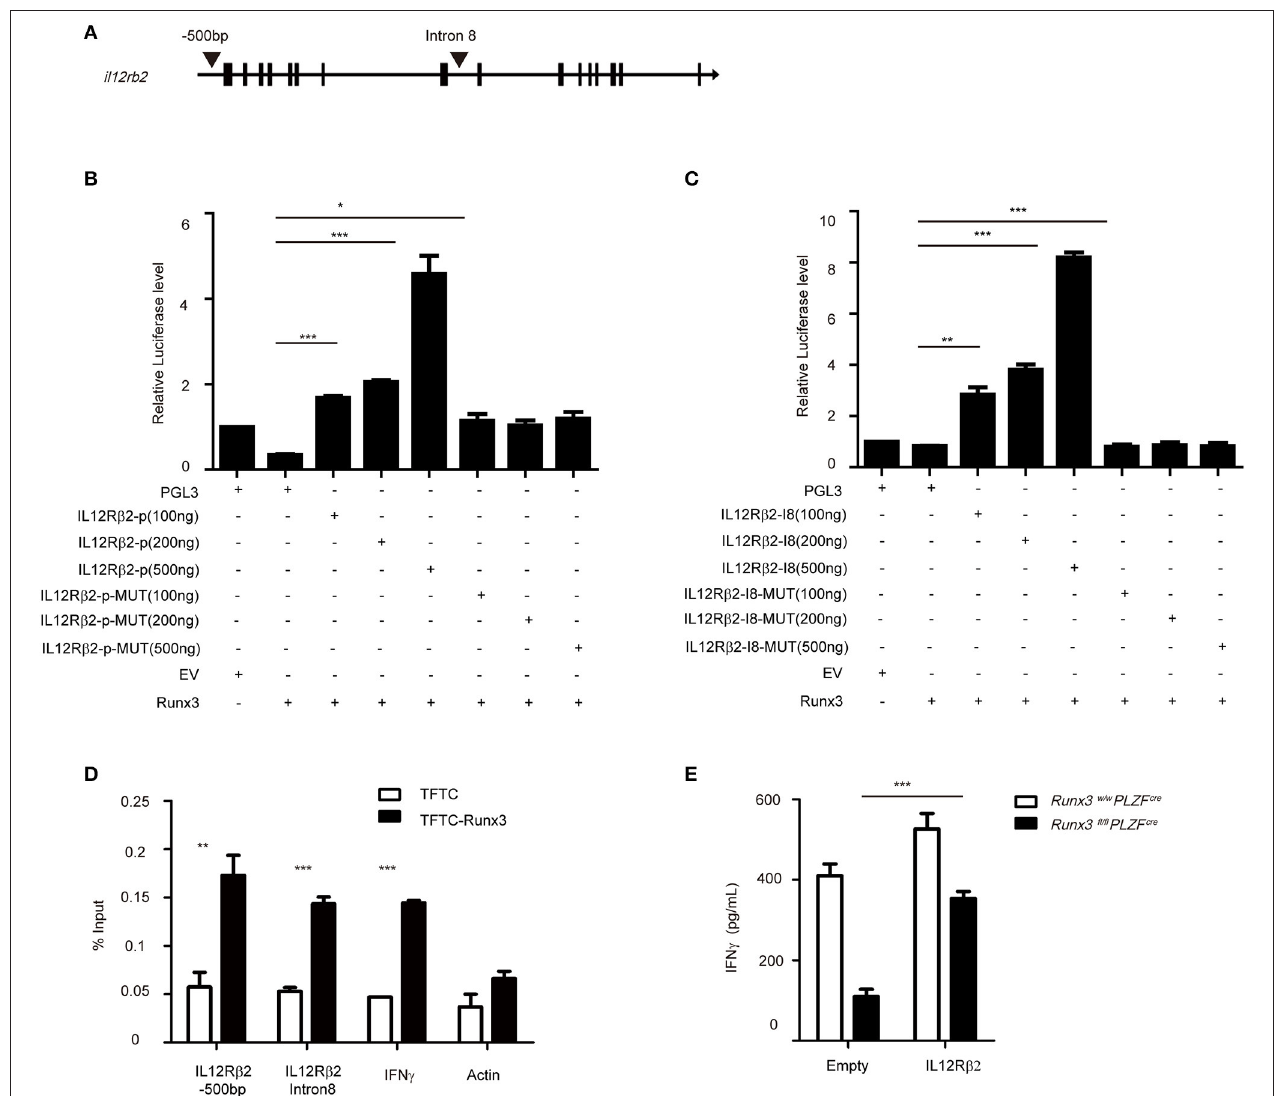
FIGURE 6 | Runx3 directly binds to the promoter and intron 8 of il12rb2 (A) Graph of the il12r2 gene and location of Runx3 binding sites. (B) Luciferase activity in HEK293 cells transfected with various combinations (below plot) of vector alone (pGL3) or with 100, 200, or 500 ng of vector containing the wild-type promoter of il12rb2 (il12rb2-p ) or with mutations in the Runx3-binding site of the promoter ( il12rb2-p-MUT ), together with empty vector (EV) or vector expressing Runx3 (Runx3). The results are presented relative to cells transfected with pGL3 and empty vector (far left), set to one. (C) Luciferase activity in HEK293 cells transfected with various combinations (below plot) of vector alone (pGL3) or with 100, 200 ng, or 500 ng of vector containing the wild-type intron 8 of il12rb2 (il12rb2-I8 ) or with mutations in the Runx3-binding site of the promoter ( il12rb2-I8-MUT ), together with empty vector (EV) or vector expressing Runx3 (Runx3). The results are presented relative to cells transfected with pGL3 and empty vector (far left), set to one. (D) Runx3 binding at the il12rb2 locus in EL4 stable cell lines expressing either a triple flag peptide (TFTC) or triple-flag-tagged Runx3 (TFTC-ROR γ t) was monitored using a flag ChIP assay. The fold enrichment of Runx3 binding at each locus was normalized to TFTC-empty EL4 cells. The actin and ifng loci were used as negative and positive controls, respectively. (E) ILC1s were sorted from wild type and cKO mice and infected with retrovirus containing the indicated vector. ELISA for IFN γ secretion with the indicated vector overexpressed in ILC1s after stimulation with IL12 and IL18 for 36h (mean ± SD of three samples in (B–E) ; * P < 0.05, ** P < 0.01 and *** P < 0.001 by Student’s t test). Data are from one experiment representative of three independent experiments with similar results in (A,C,D) and two independent experiments with similar results in (E)